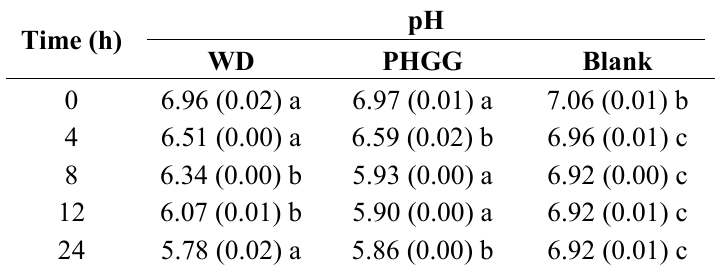
Table 1. pH Shift in Batch Culture Fermentation System with WD and PHGG Across 24 h of